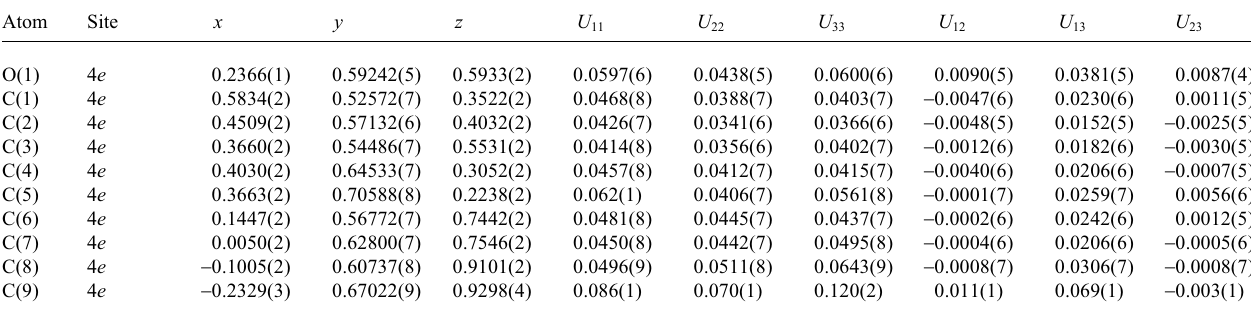
Table 3. Atomic coordinates and displacement parameters (in Å 2 )